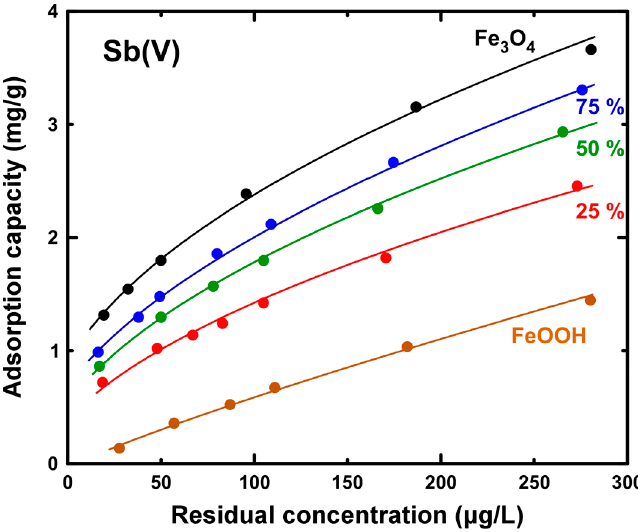
Figure 6. Adsorption isotherms of studied Fe 3 O 4 /FeOOH nanocomposites for Sb(V) taken in natural-like water adjusted at pH 7. Curves correspond to the Freundlich-type fitting.